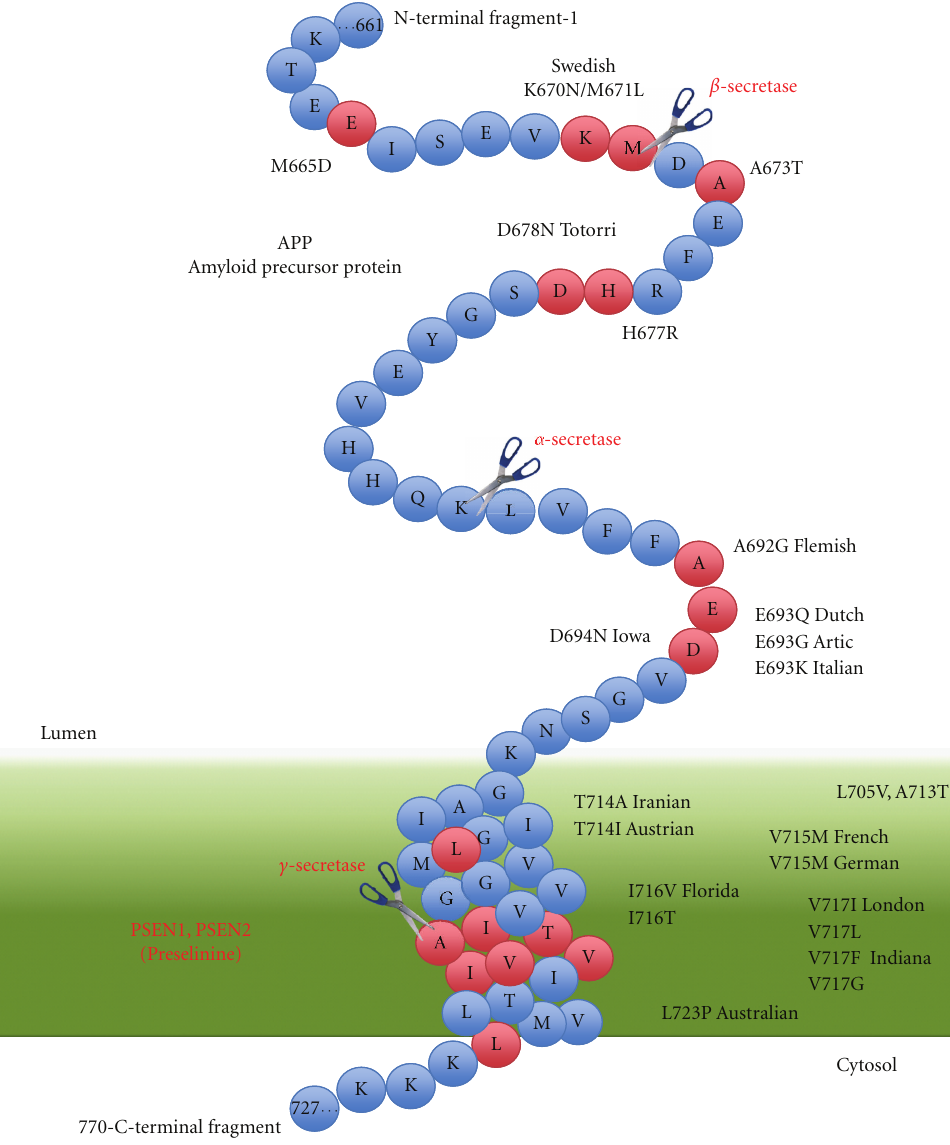
Figure 1: Amyloid precursor protein (APP) cleavage and mutation. The present diagram represent APP, a transmembrane protein precursor of A β peptide, with the three principal cleavage site ( β -secretase or BACE, α -secretase, and γ -secretase) and several known